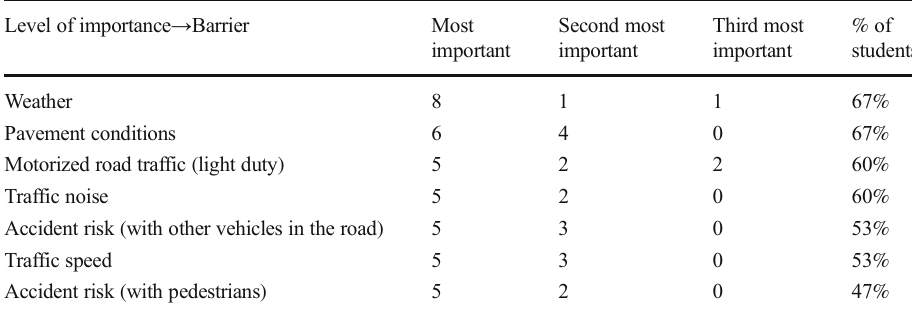
Table 1 Perceived barriers of students with e-bike